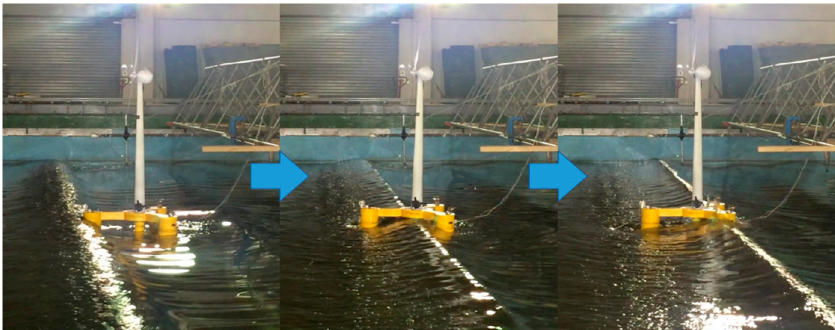
Figure 2. Floating offshore wind turbine model experiment in the University of Ulsan’s ocean engineering wide tank.